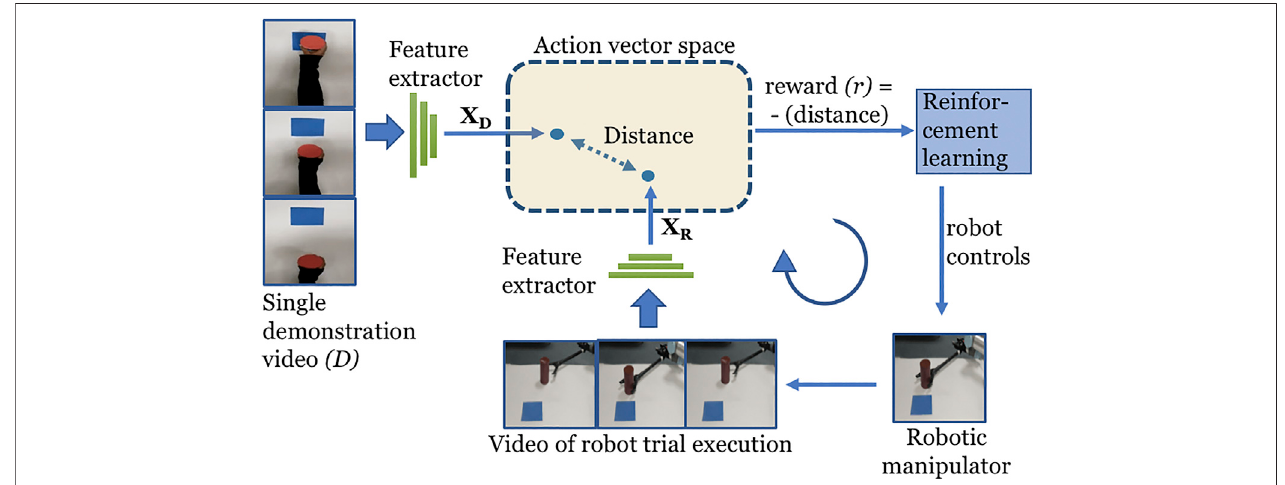
FIGURE 1 | Overview of O 2 A method. A 3D-CNN action vector extractor is used to extract action vectors ⃗ X robottrialexecutionrespectively.Areward functionisused tocompare ⃗ X reinforcement learning algorithm then iteratively learns an optimal control policy by maximizing this reward signal, thus enabling observational